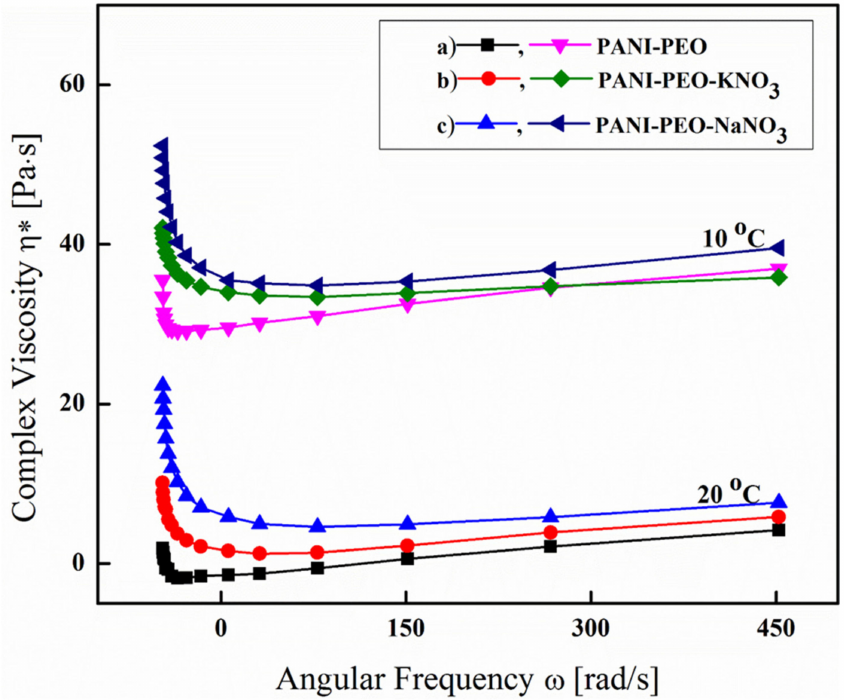
Figure 10. Rheogram of ( a ) PANI-PEO ( b ) PANI-PEO-NaNO 3 and ( c ) PANI-PEO-KNO 3 depicting dependence of complex viscosity on angular frequency at 10 ◦ C and 20 ◦